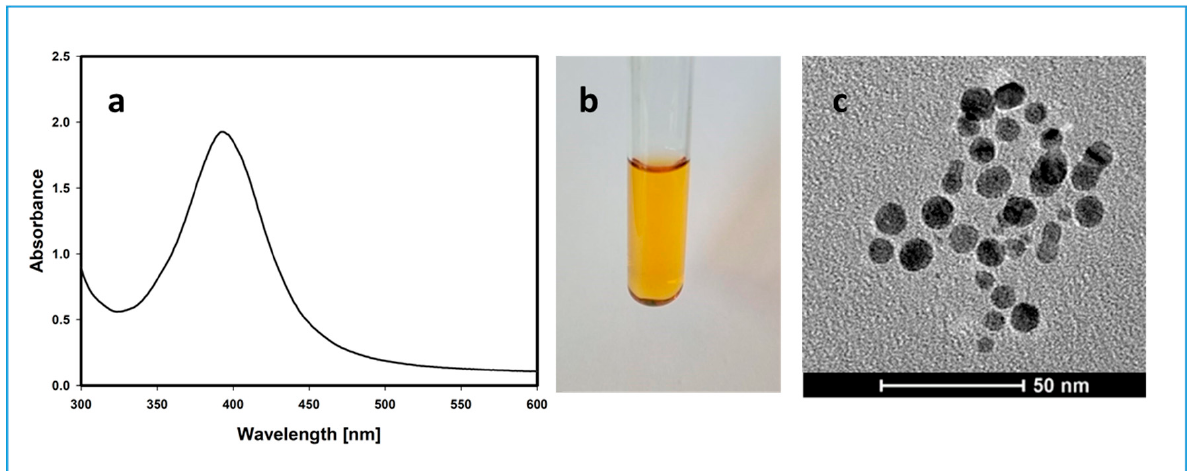
Figure 1. Silver nanoparticles prepared by a chemical reduction of silver ions using borohydride; ( a ) characteristic UV-visible (UV/Vis) spectrum, with the maximum absorbance at 395 nm; ( b ) color of the solution; ( c ) transmission electron microscope image of the synthesized silver nanoparticles.